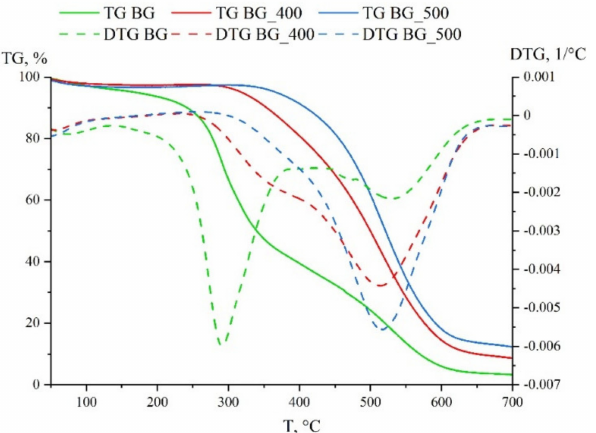
Figure 4. Thermal behaviour (TG and DTG curves) of brewery grains (BG) and biochars (BG_400 and BG_500) under air atmosphere (combustion